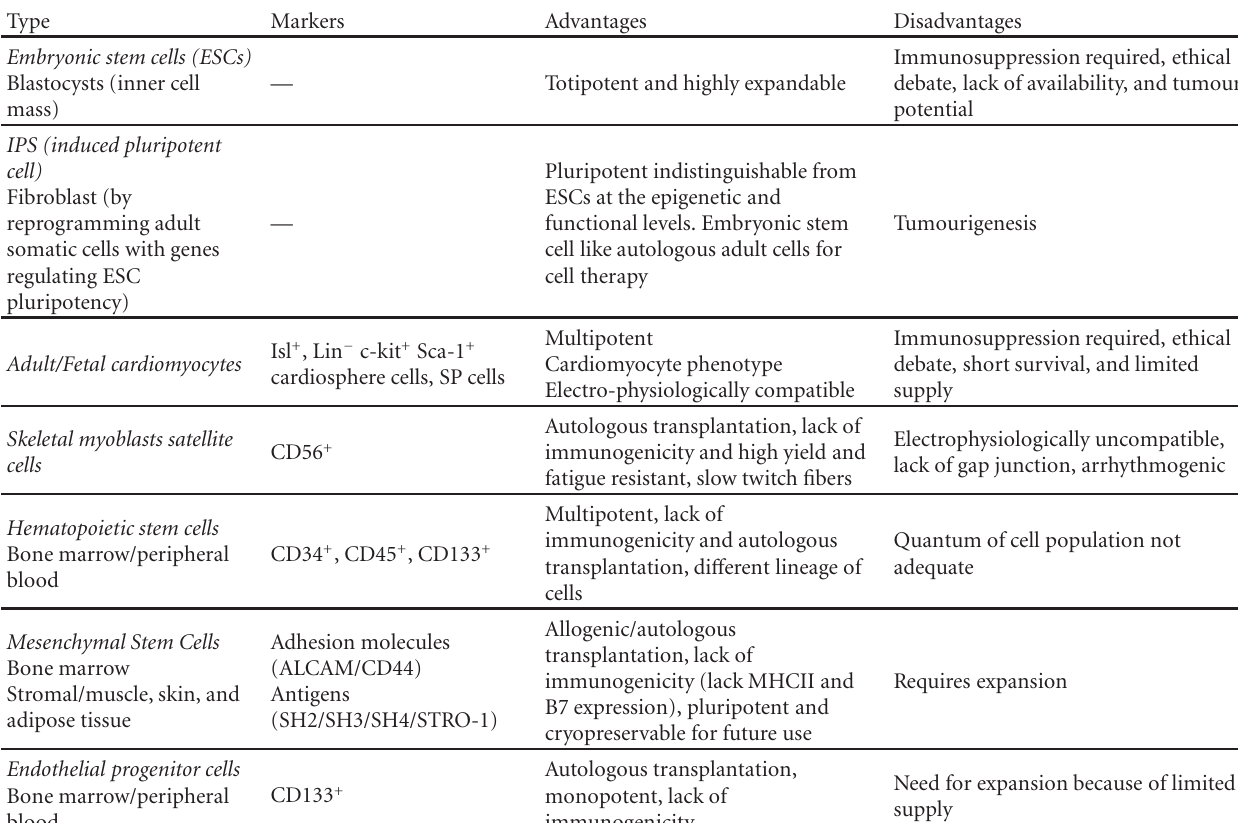
Table 2: Major cell types with potentials for cardiac cell